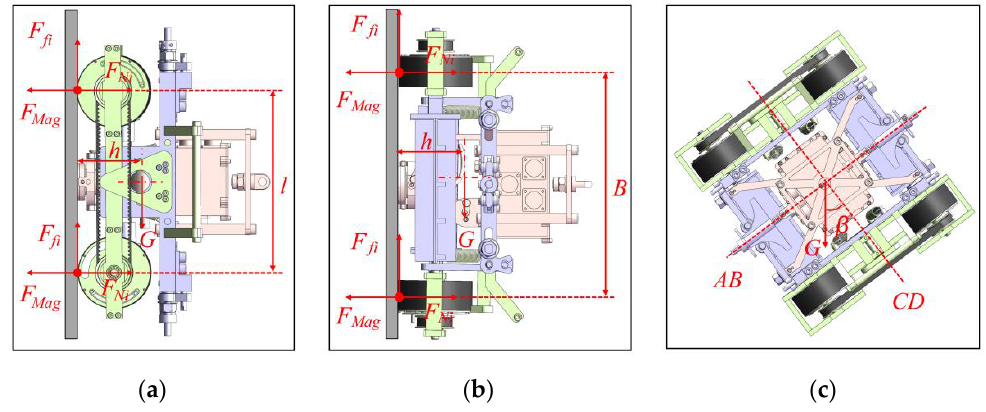
Figure 6. Static model of robot: ( a ) Vertical state, ( b ) horizontal state, and ( c ) oblique state.